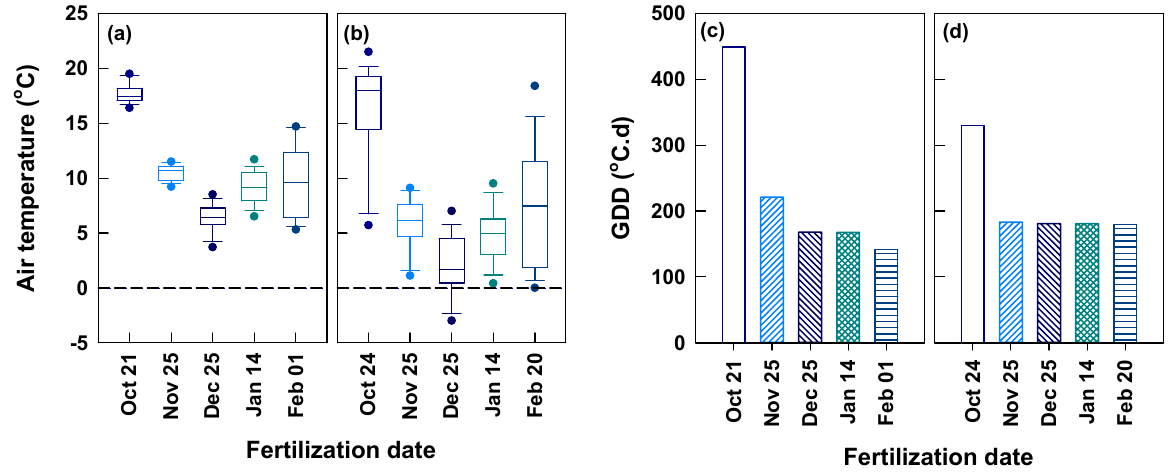
Figure 2. Periodic mean air temperature within 15 days after fertilization ( a , b ) and growing degree days (GDD, ≥ 8 °C) between the fertilization dates and the first harvest of spring tea ( c , d ) at Yongchuan ( a , c ) and Xingyang ( b , d ).